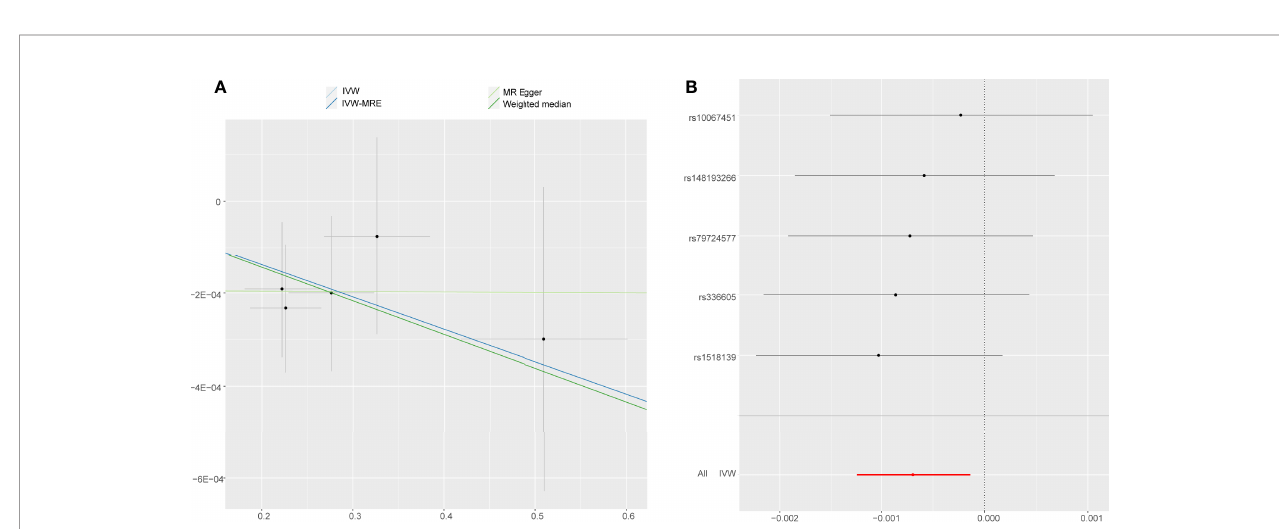
FIGURE 3 | Forest plot and scatter plot of the association of accelerometer-based PA (average acceleration) with the risk of AS. (A) Scatter plot: each black dot indicates a SNP, plotted by the estimate of SNP on accelerometer-based PA (average acceleration) and the estimate of SNP on the risk of AS with standard error bars. The slopes of the lines correspond to causal estimates using each of the different methods. (B) Forest plot: the dot and bar indicate the causal estimate of accelerometer-based PA (average acceleration) on risk of